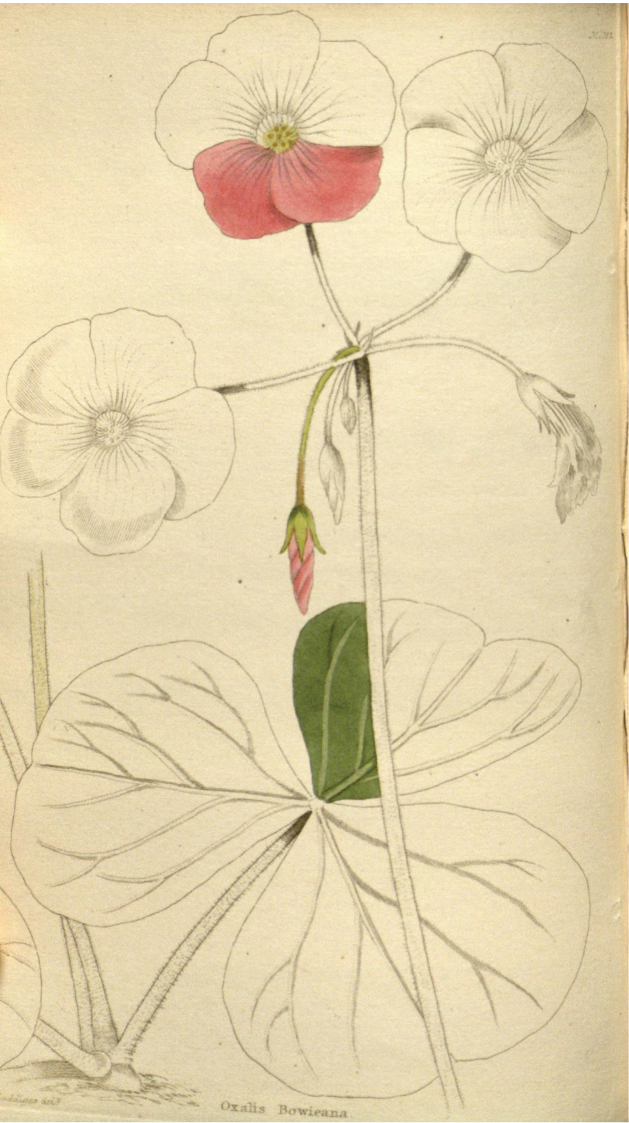
The illustration of Oxalisbowiei (as Oxalisbowieana) from The Botanical Cabinet (Loddiges 1832). https://biodiversitylibrary.org/page/29151292